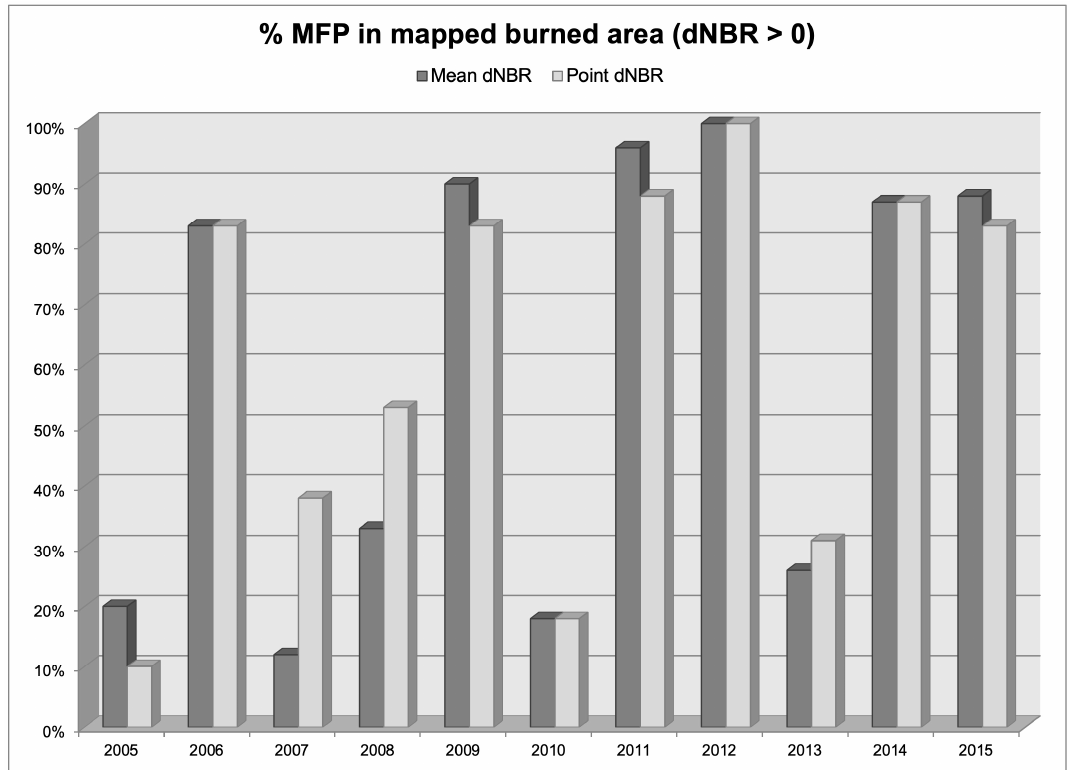
Figure 5. Percentage of MODIS active fire detection points (MFP) located in mapped burned areas from Landsat ETM+ and OLI data 2004–2005 to 2014–2015.